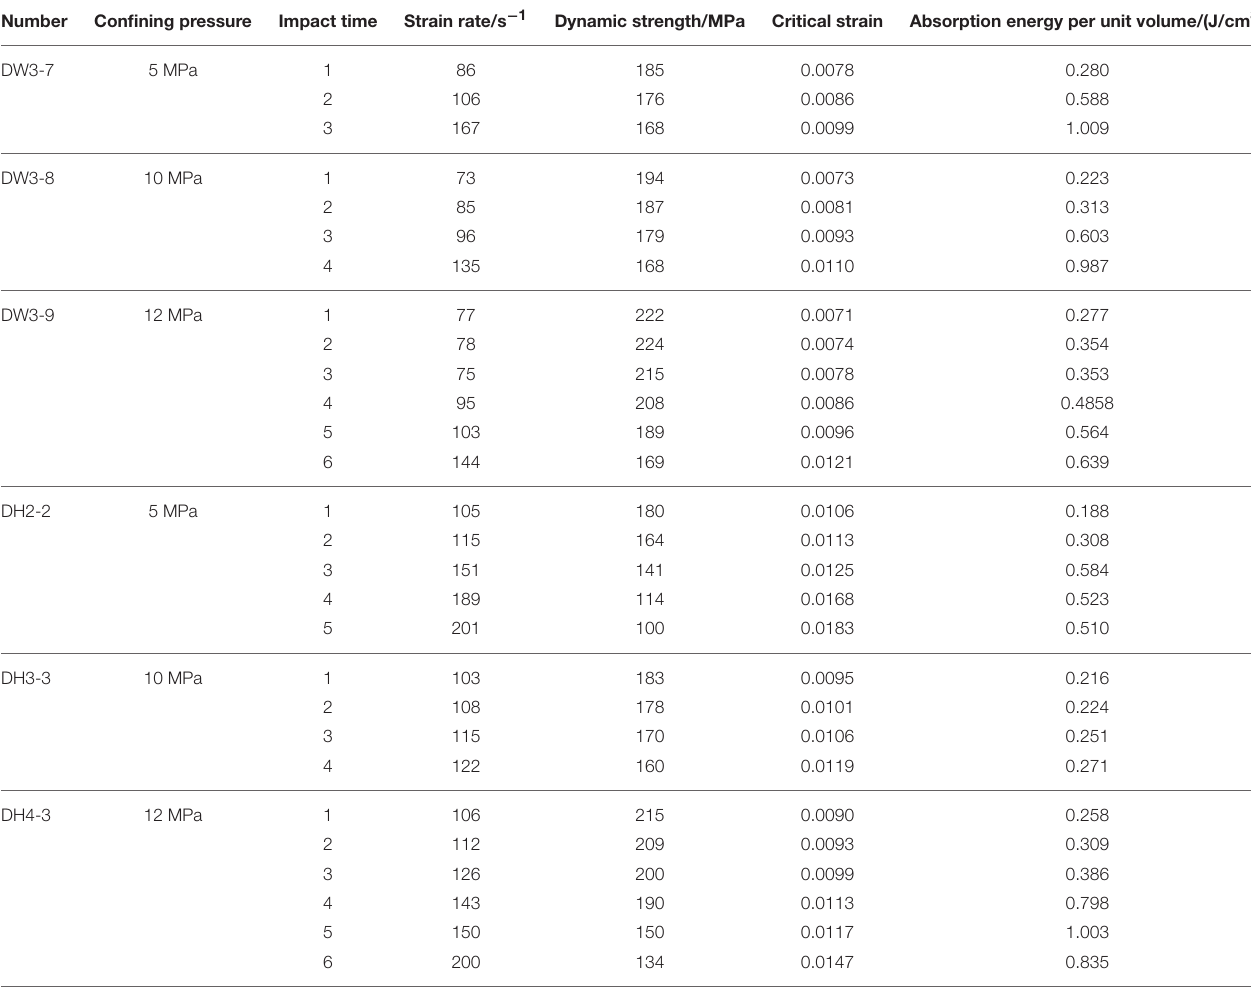
TABLE 2 | Mechanical properties of sandstone under cyclical impact